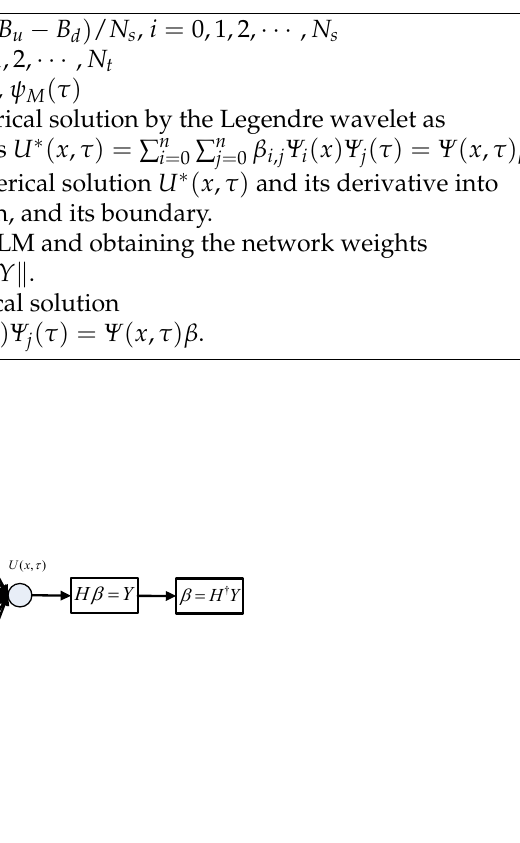
Algorithm 2 The procedure for solving the European options pricing model based on the LWNN-ELM.